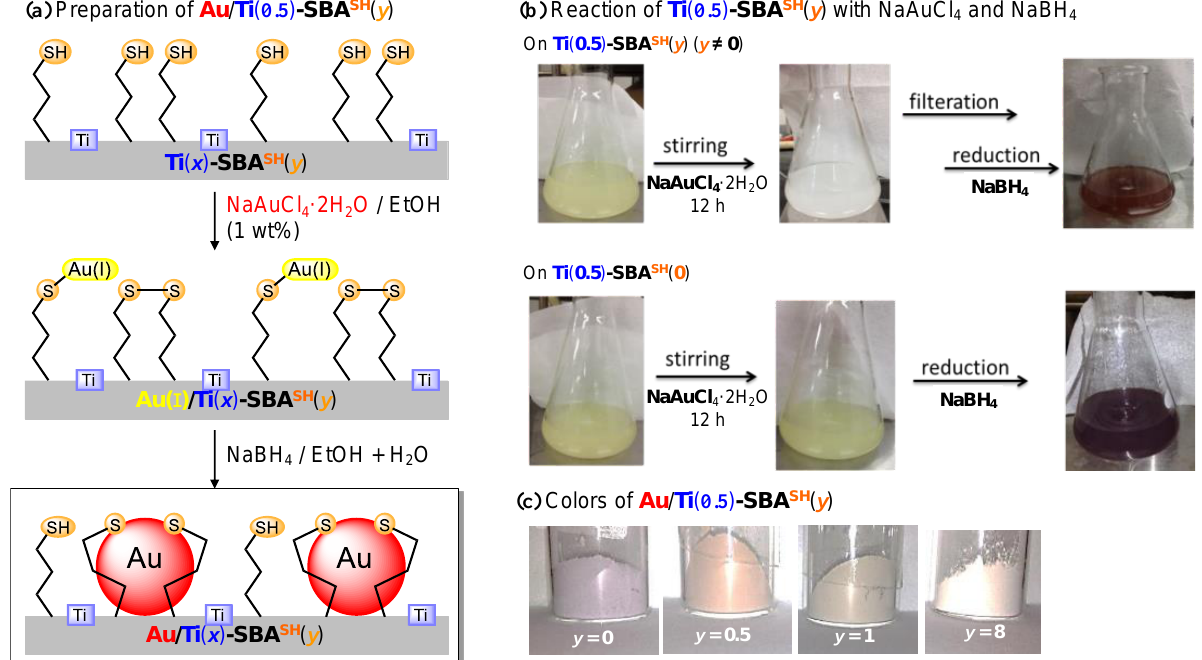
Figure 2. Preparation of Au-immobilized catalysts Au/Ti( x )-SBA SH ( y ): ( a ) A synthetic procedure. ( b ) Reaction mixture of the supports with NaAuCl 4 ·2H 2 O and reduction by NaBH 4 . ( c ) Colors of the obtained Au-immobilized catalysts.